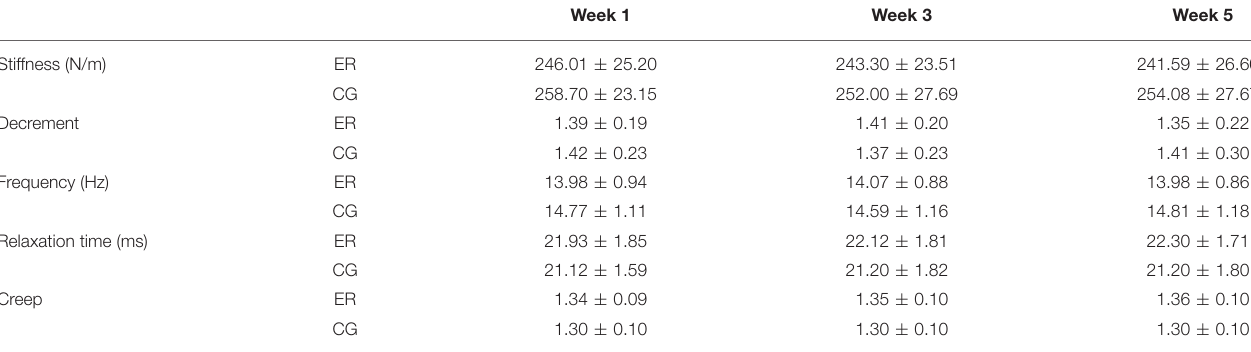
TABLE 4 | Overview of the MyotonPRO analysis [energy-restricted group (ER), control group